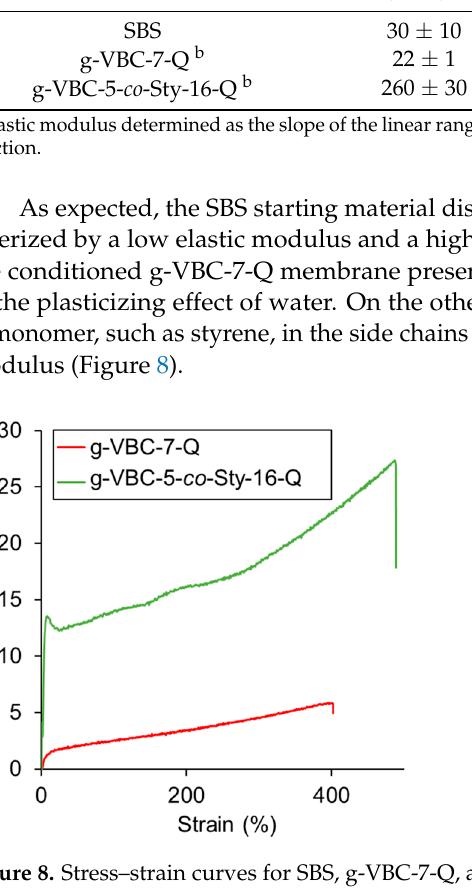
Table 5. Electrochemical properties of the aminated membranes.